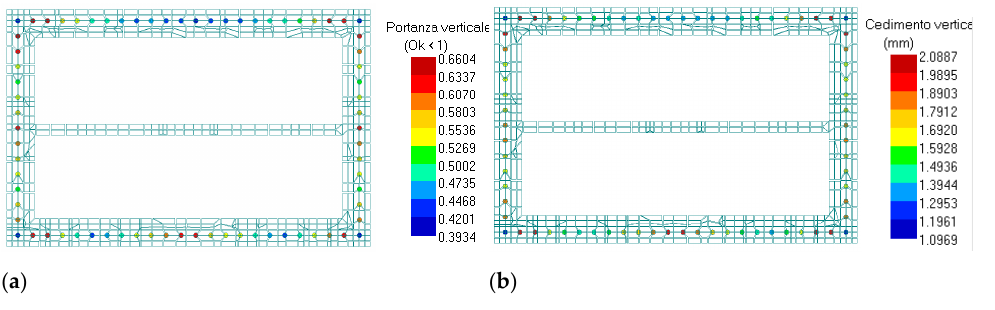
Figure 19. Results of the bearing capacity ( a ) and subsidence ( b ) for the existing foundations.